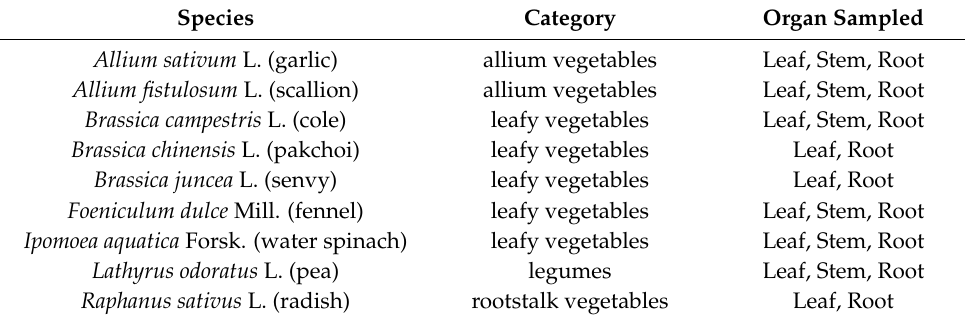
Table 1. Vegetable crop species collected from the farmland around the tailings